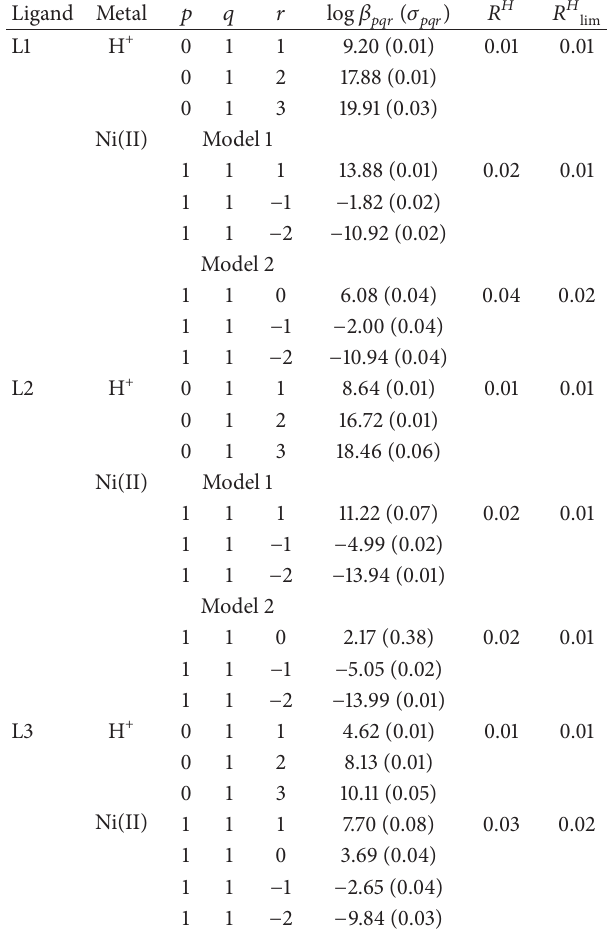
Table 1: Formation constants (log 𝛽 𝑝𝑞𝑟 ) for Ni(II) complexes of L1, L2, and L3, 𝛽 𝑝𝑞𝑟 = [ M 𝑝 L 𝑞 H 𝑟 ] / [ M ] 𝑝 [ L ] 𝑞 [ H ] 𝑟 , 𝐼 = 0.15 moldm −3 (NaCl), and 𝑇 = 25 ∘ C.